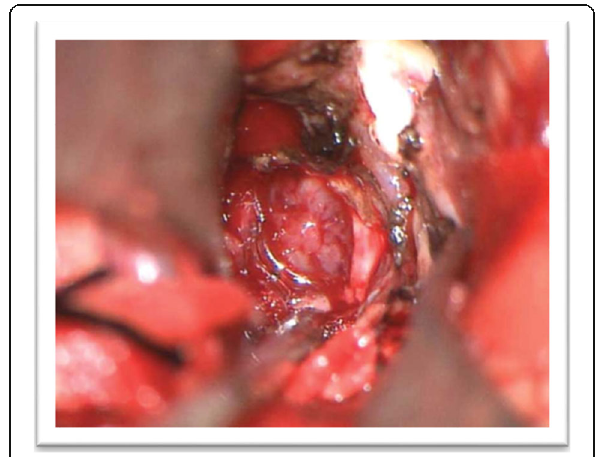
Fig. 1 The dura over the midline of the posterior cranial fossa is opened by a Y-shaped incision, the two arms of the Y extending to the transverse sinus and the vertical leg of the Y heading in the cervical direction